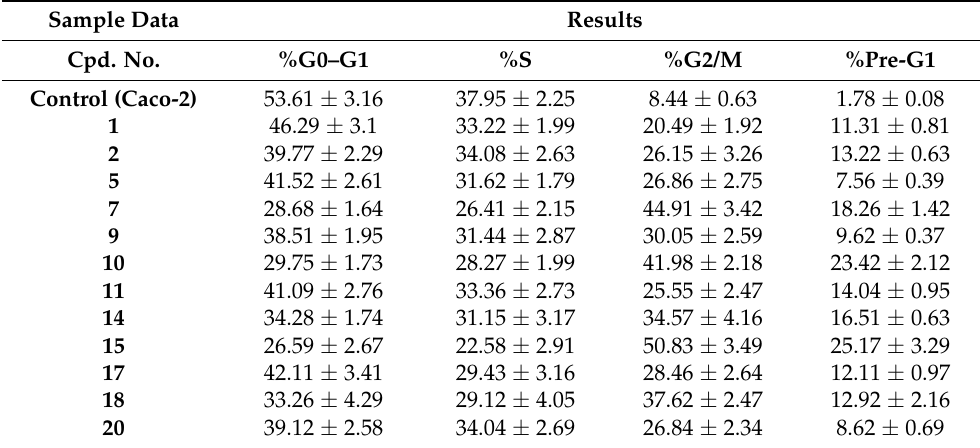
Table 4. Cell-cycle analysis of Caco-2 cells following treatment with the parent compounds and their derivatives. Sample Data Cpd.